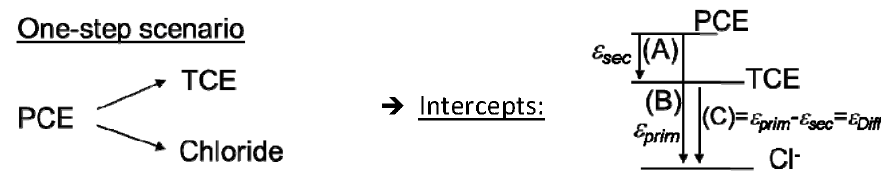
Figure 4. Interpretation of chlorine isotope data in a one-step scenario with respect to intercepts between PCE, TCE and chloride of the applied mathematical fits.